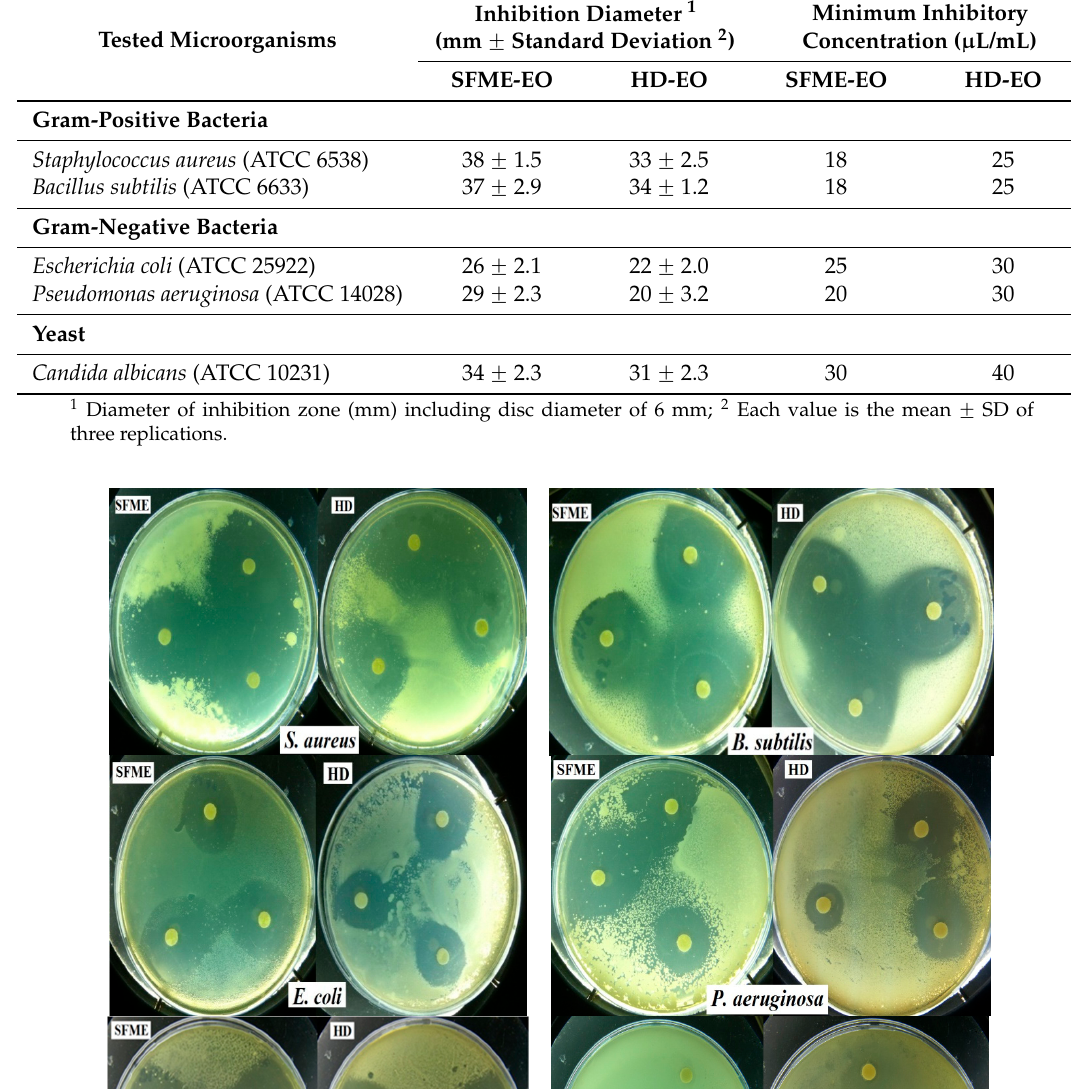
Tested Microorganisms Table 4. Result of antimicrobial activity of sweet basil EO obtained by SFME and HD.